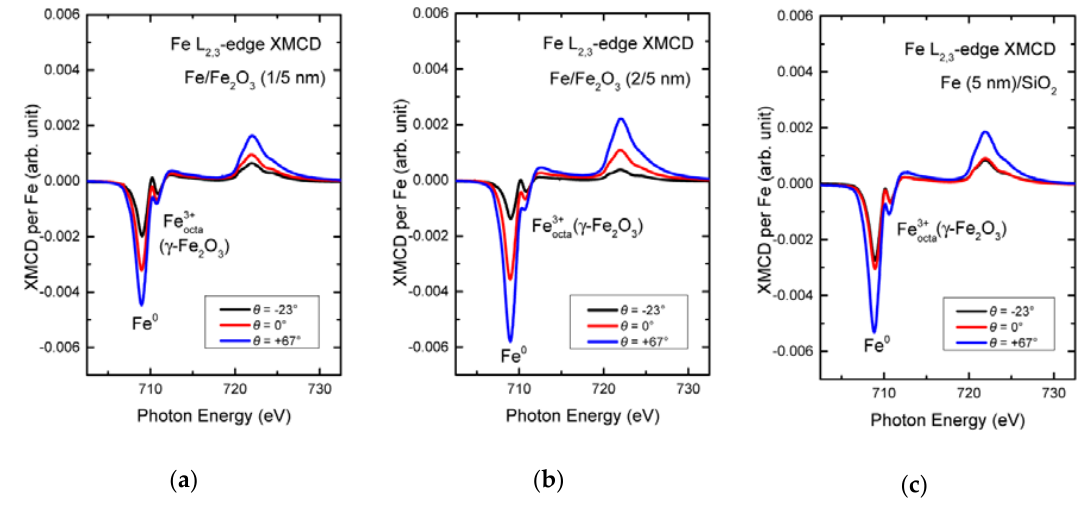
Figure 5. Fe L 2,3 -edge XMCD spectra normalized as to represent the signals per Fe atom at different θ ’s of ( a ) 1/5 nm, ( b ) 2/5 nm and ( c ) Fe (5 nm) samples. Overall XMCD intensity increases according to the incidence angle of the magnetic field (not the X-rays), indicating that the easy direction of the Fe and γ -Fe 2 O 3 spins lie in the sample planes for all the samples.